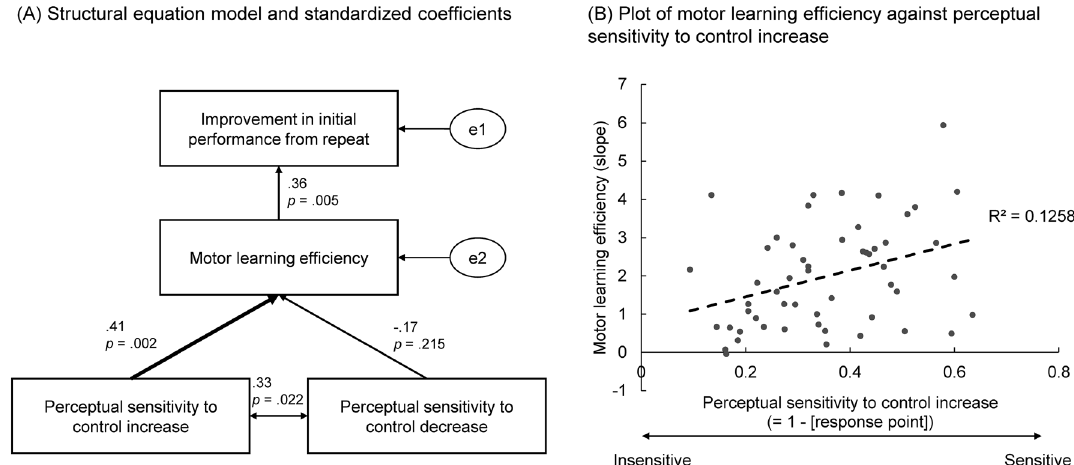
Figure 5. Structural equation model of sense of agency and adaptive motor learning ( A ), and the plot of learning efficiency against perceptual sensitivity of control increase ( B ).